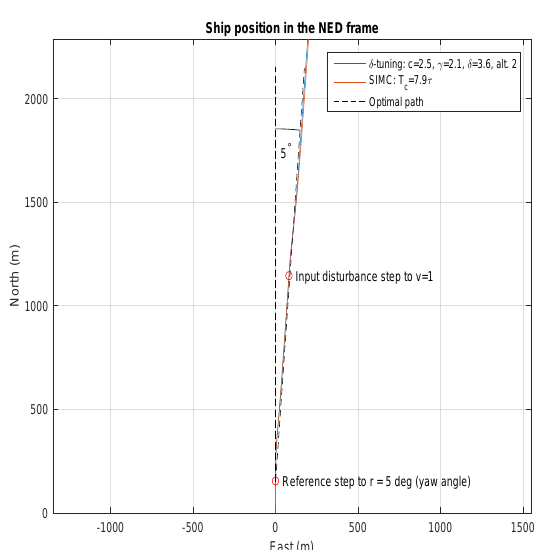
Figure 18: Shows PID control of the non-linear vessel model in Eq. (49). The PID controller is tuned using δ -tuning Alg. 2.1 and Eq. (27), with prescribed robustness δ = 3 . 6 and tune alternative 2. Reference step, r = 5 deg, at time = 20 s. Input disturbance step, v = 1, is introduced at time = 150 s.